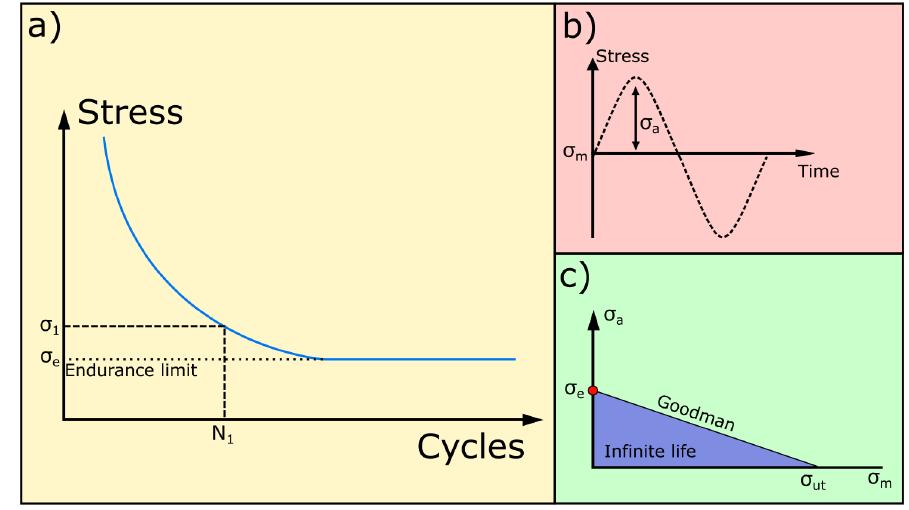
Figure 1. ( a ) example of an S–N curve illustrating fatigue of an arbitrary component where failure would occur for a stress of σ 1 after N 1 cycles; ( b ) one cycle of a typical sinusoidal fatigue test and ( c ) the Goodman relation. The Goodman relation states that for a stress amplitude, σ a , less than the endurance limit, σ e , no fatigue shall occur and infinite life should be